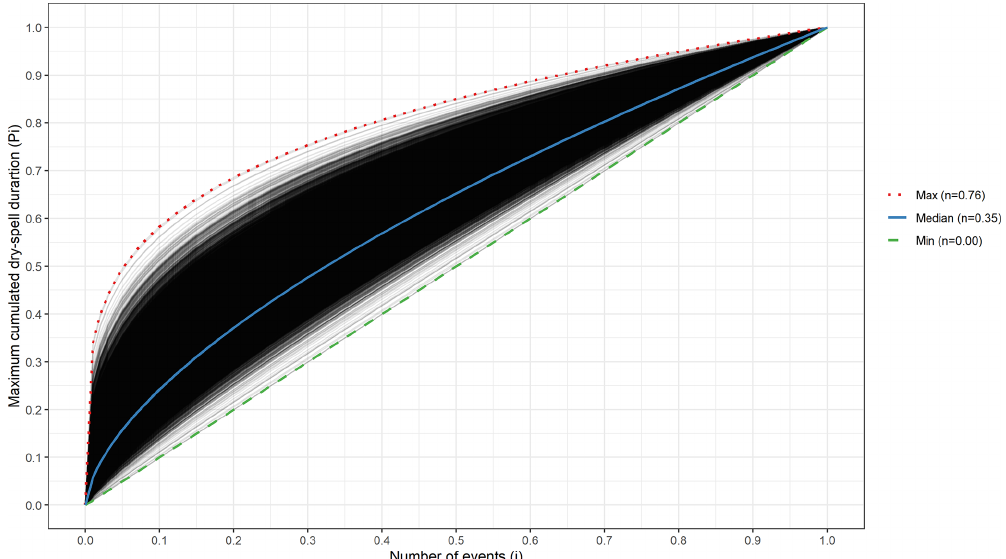
Figure A4. Fitted curves of DSS events (Eq. 4), according to the maximum accumulated dry-spell duration ( P i ) over the number of events considered ( i ), both normalised according to the total